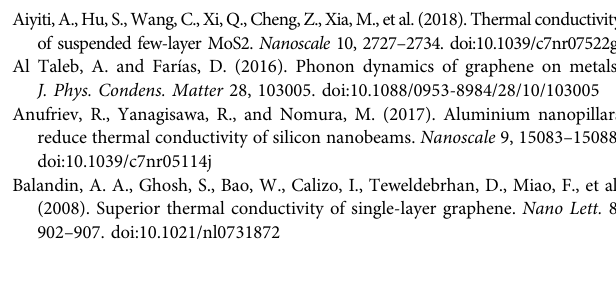
Frontiers in Materials |